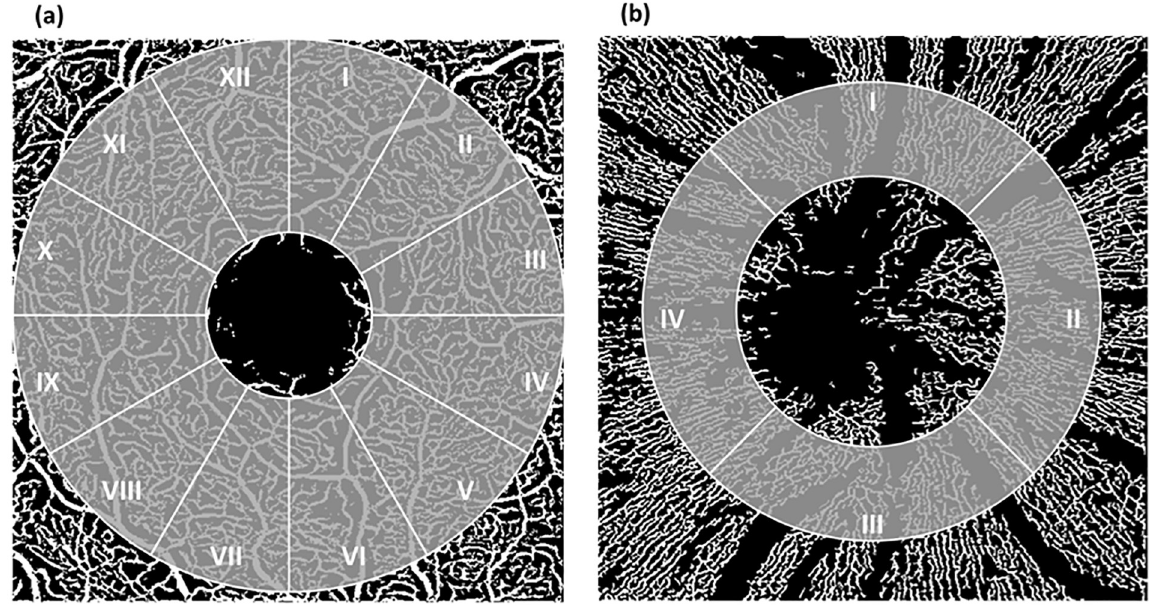
Fig 2. Region of interest of OCT-A scans analyzed with the Erlangen Angio Tool: Macula (subdivided into 12 sectors, a) and peripapillary region (subdivided into 4 sectors, b).